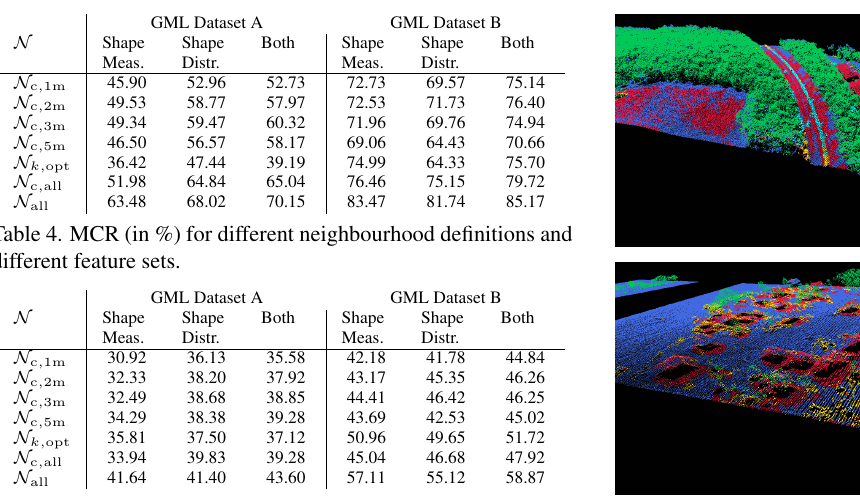
Figure 3. Visualisation of the classification results for GML Dataset A (top) and GML Dataset B (bottom) with the classes ground (blue), building (red), car (cyan), tree (green) and low vegetation